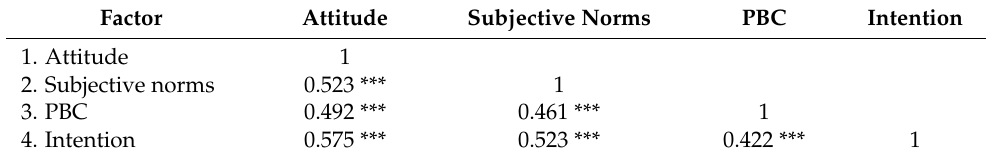
Table 3. Correlation analysis ( n =